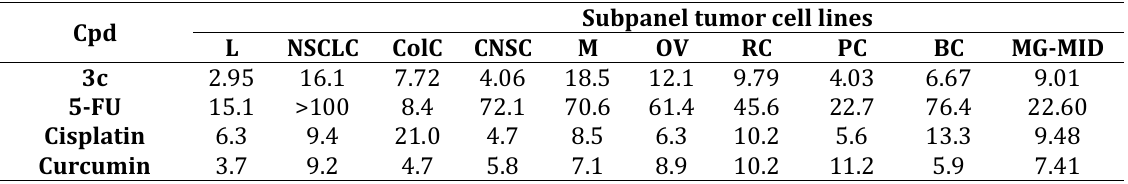
Table IV. Mean growth inhibitory concentration (GI50, µM) of compound 3c in comparison with 5-FU, Cisplatin and